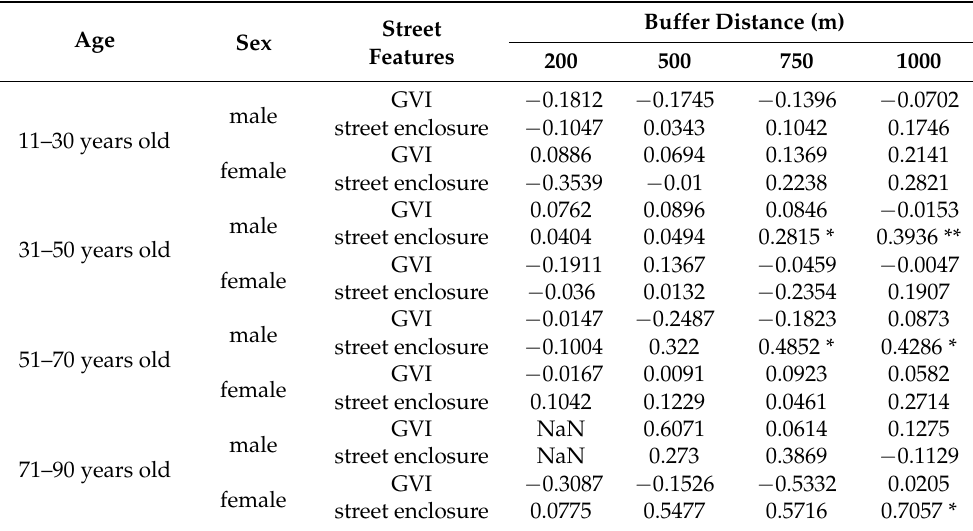
Table 3. Pearson correlation coefficients between GVI and enclosure and the number of cases at different buffer distances and in different sex and age .